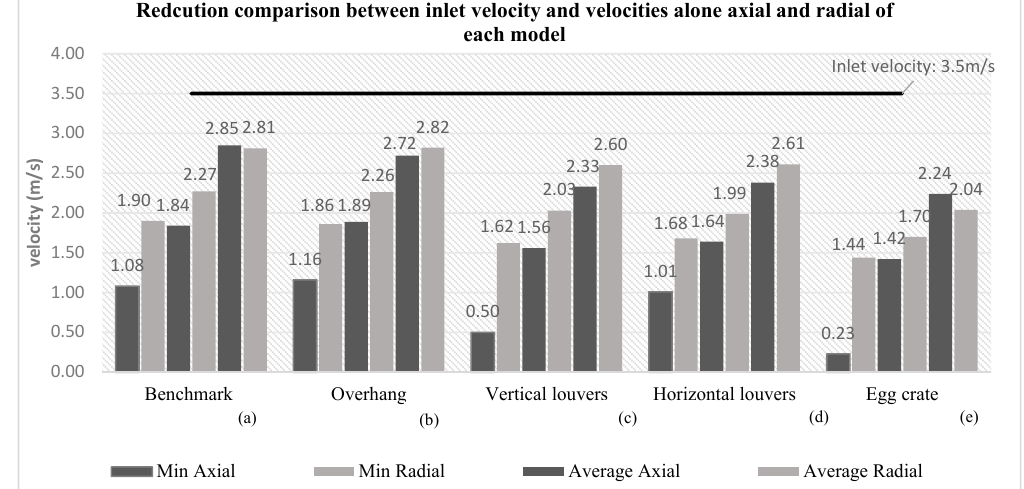
Figure 11. Comparison in reductions between inlet velocity and velocities alone axial and radial direction of each model